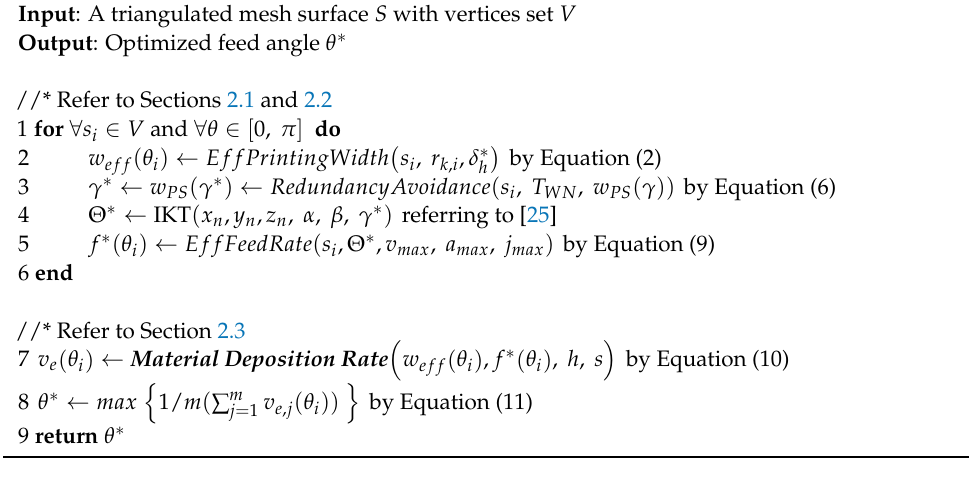
Algorithm 1 Optimized feed direction determination